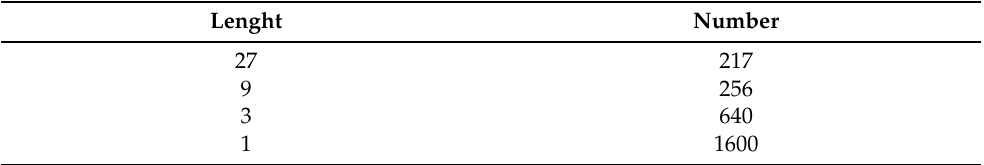
Table 3. The number of segments of a level-3 Menger sponge complement for each length, in each di- rection.